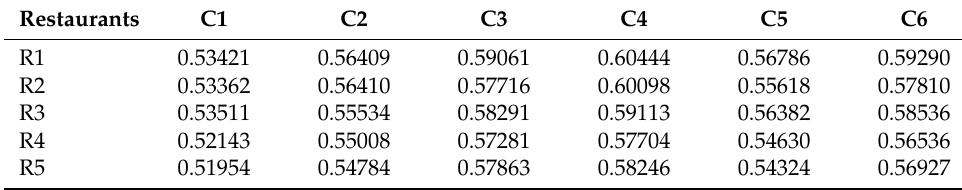
Table 14. The equivalent crisp dataset for the evaluation of